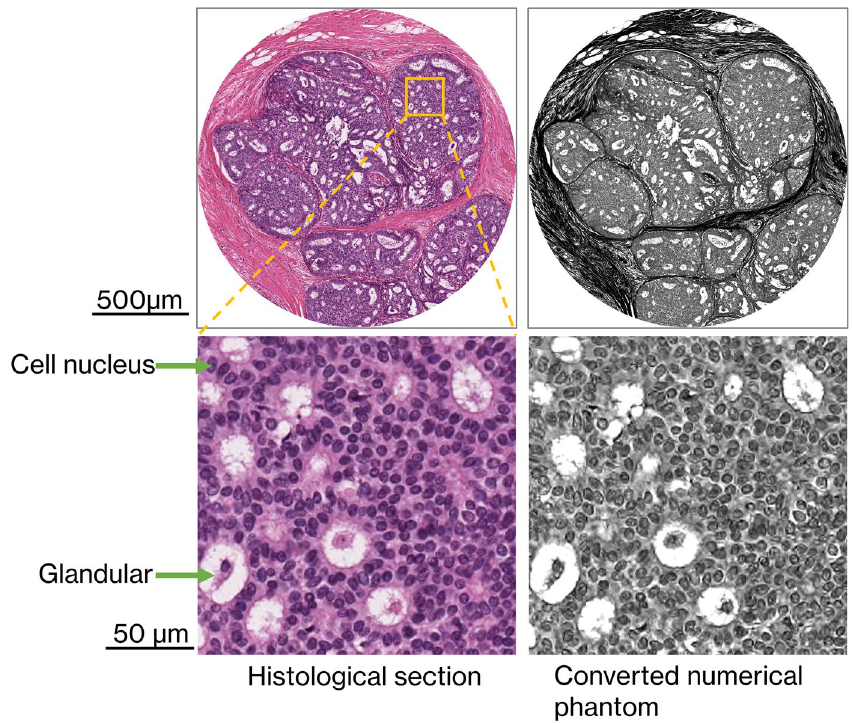
Figure 11. A histological section of a breast tissue specimen stained with hematoxylin and eosin and a numerical phantom image generated from ( a